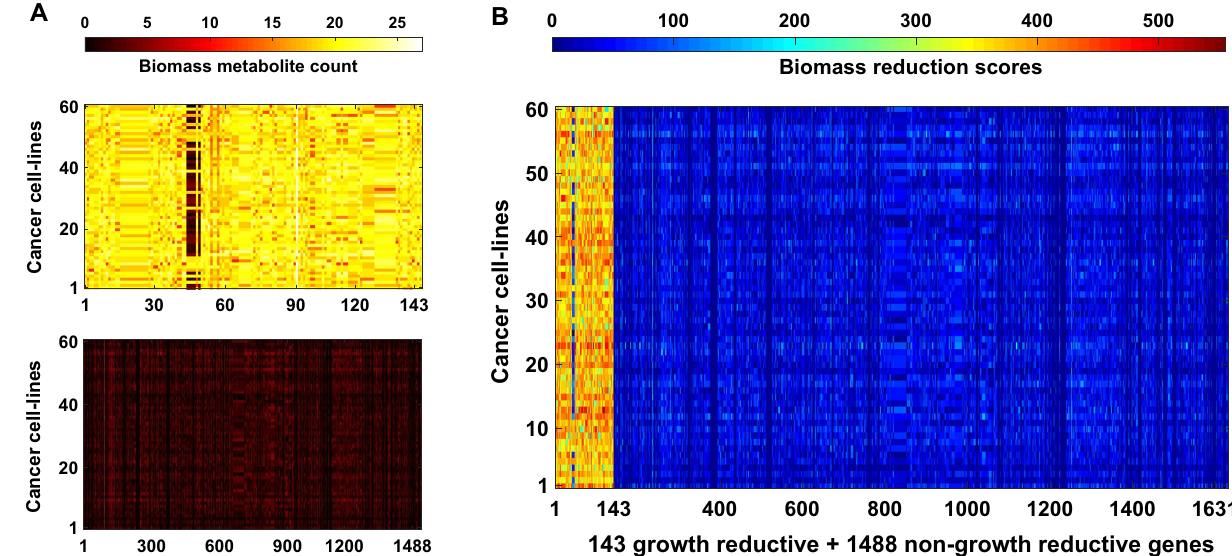
Figure 3. Effect of metabolic genes on biomass function. ( A ) The upper and lower panels indicate the number of biomass metabolites whose production flux at least twofolds decreased by each of the 143 growth reducing genes and 1488 non-growth reducing genes, respectively. For the details of these genes, see Supplementary File S1. ( B ) Biomass reduction scores (BRS) of genes following synergic effect. BRS is high for first 143 growth reducing genes and it is low for 1488 non-growth reducing